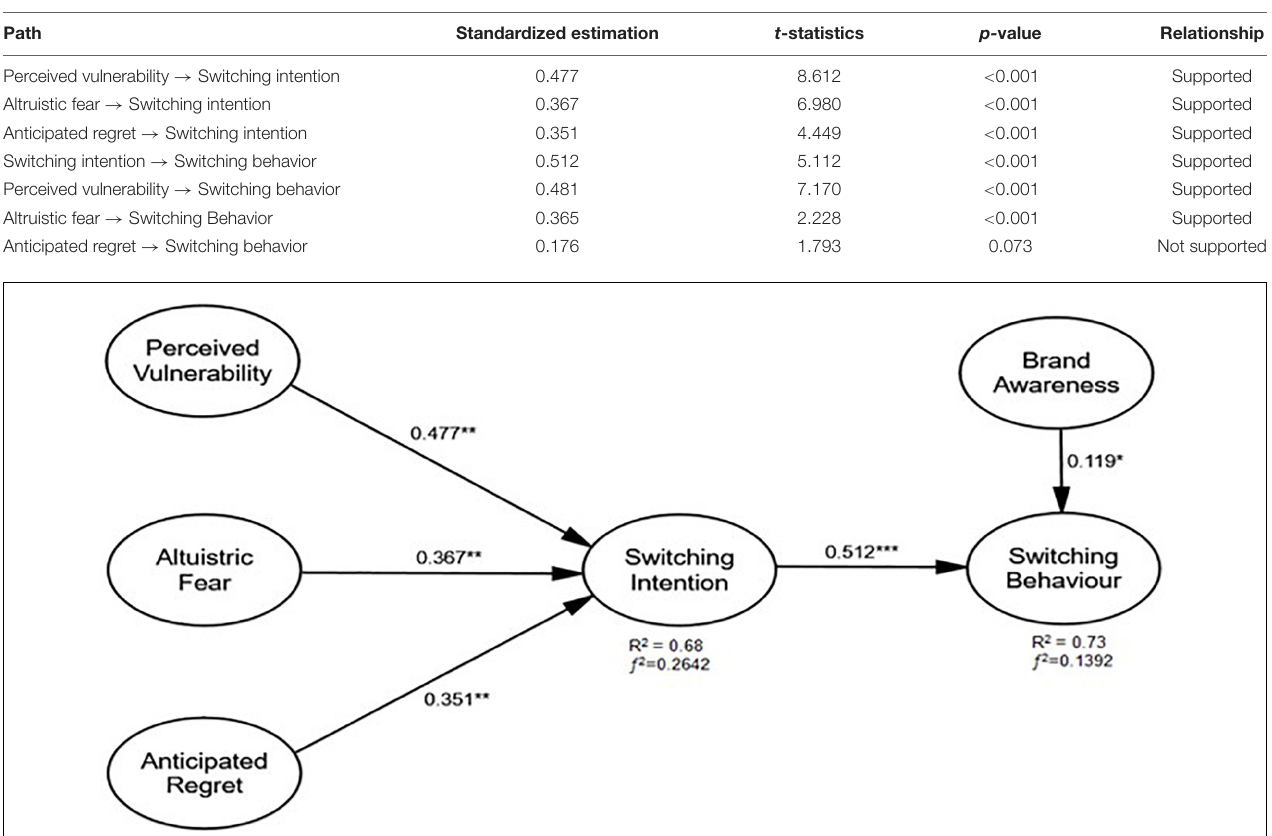
TABLE 6 | Hypothesis result.